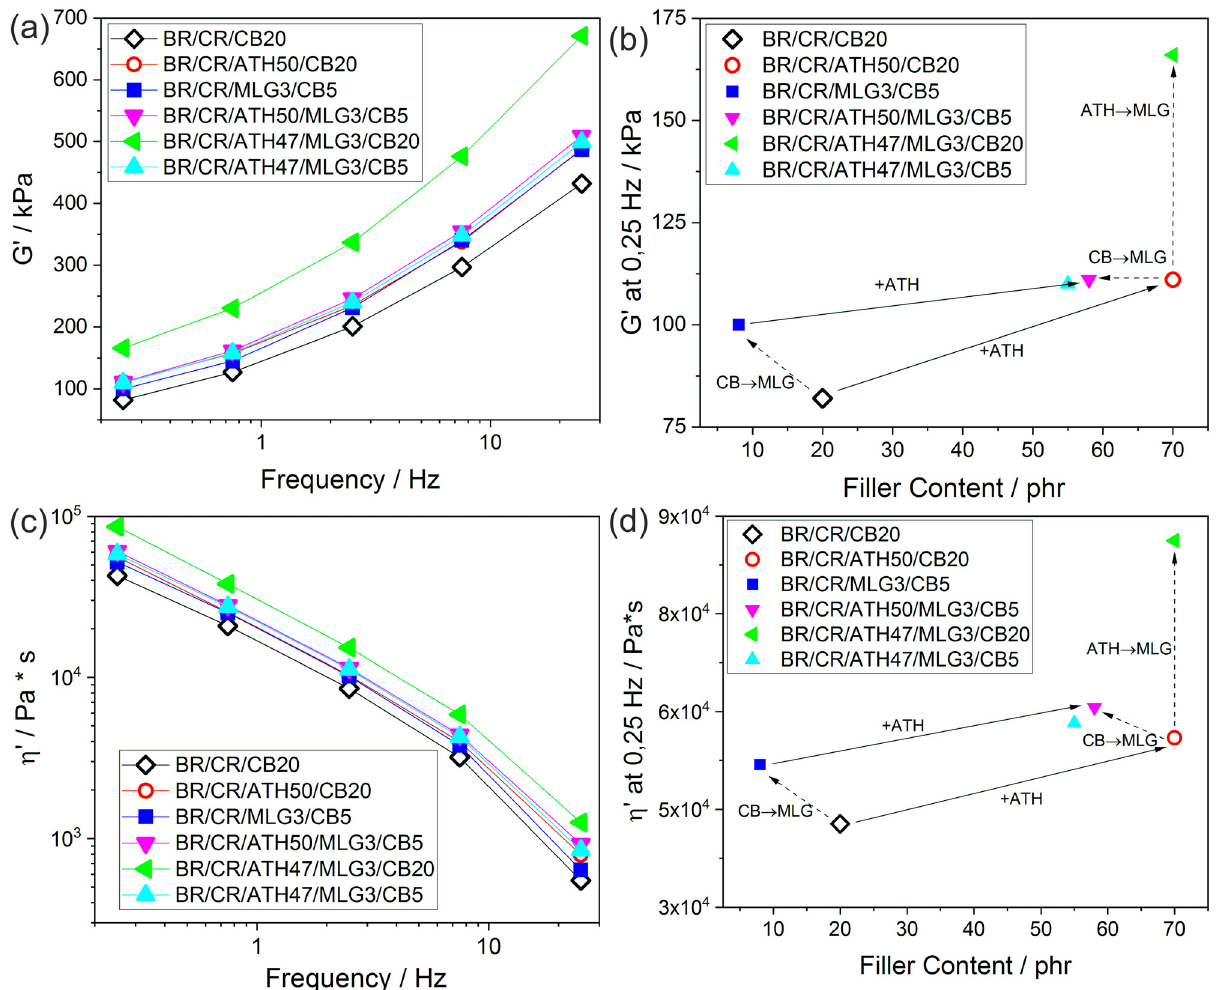
Figure 3: Rheology of uncured rubber composites: frequency sweep; ( a ) storage modulus over frequency, ( b ) storage modulus at 0.25 Hz vs fi ller content, ( c ) dynamic viscosity over frequency, and ( d ) dynamic viscosity at 0.25 Hz vs fi ller content. For ( b ) and ( d ) : solid line is the addition of 50 phr of ATH; dashed line is the substitution of 15 phr CB with 3 phr MLG, or 3 phr ATH with 3 phr MLG,